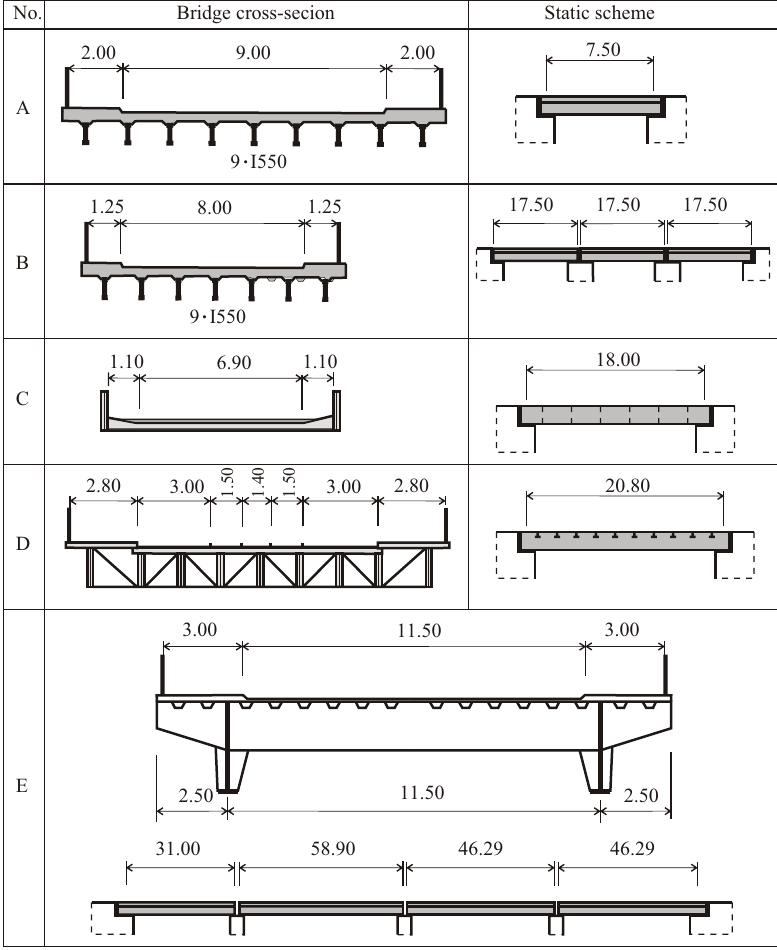
Figure 1. Static schemes of bridge structures that were tested within the research on the randomness of road traffic,